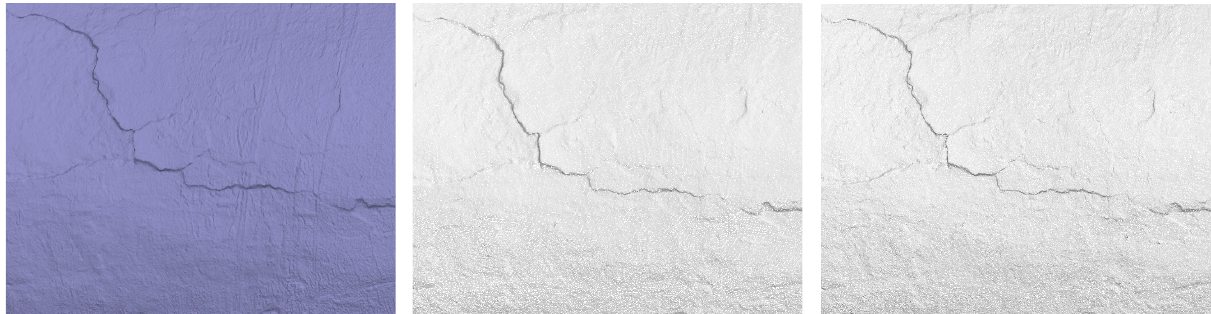
Figure 13. On the left, the mesh from the scanner survey. In the centre, The photogrammetric point cloud in high quality. On the right, the photogrammetric point cloud in ultra-high